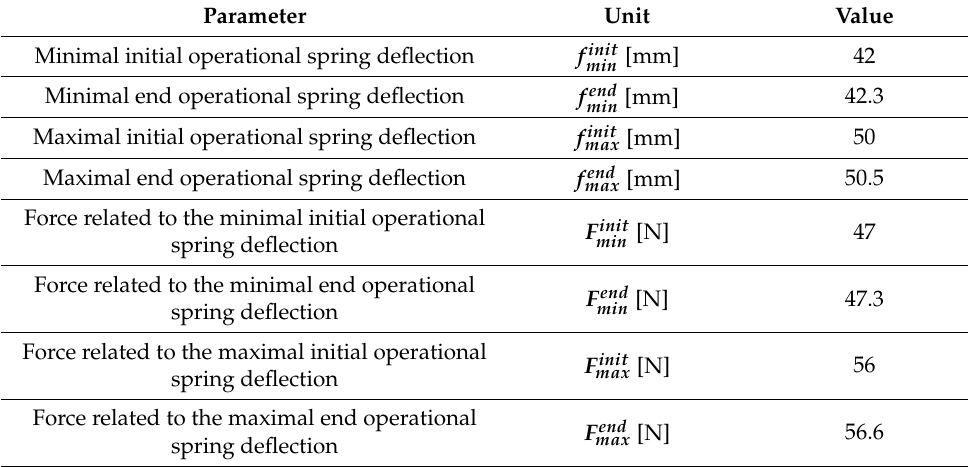
Table 8. The spring deflections and the respective forces loading the contact zone between the movable plunger 2 and the shaft shoulder 1 (Figure 7). Parameter